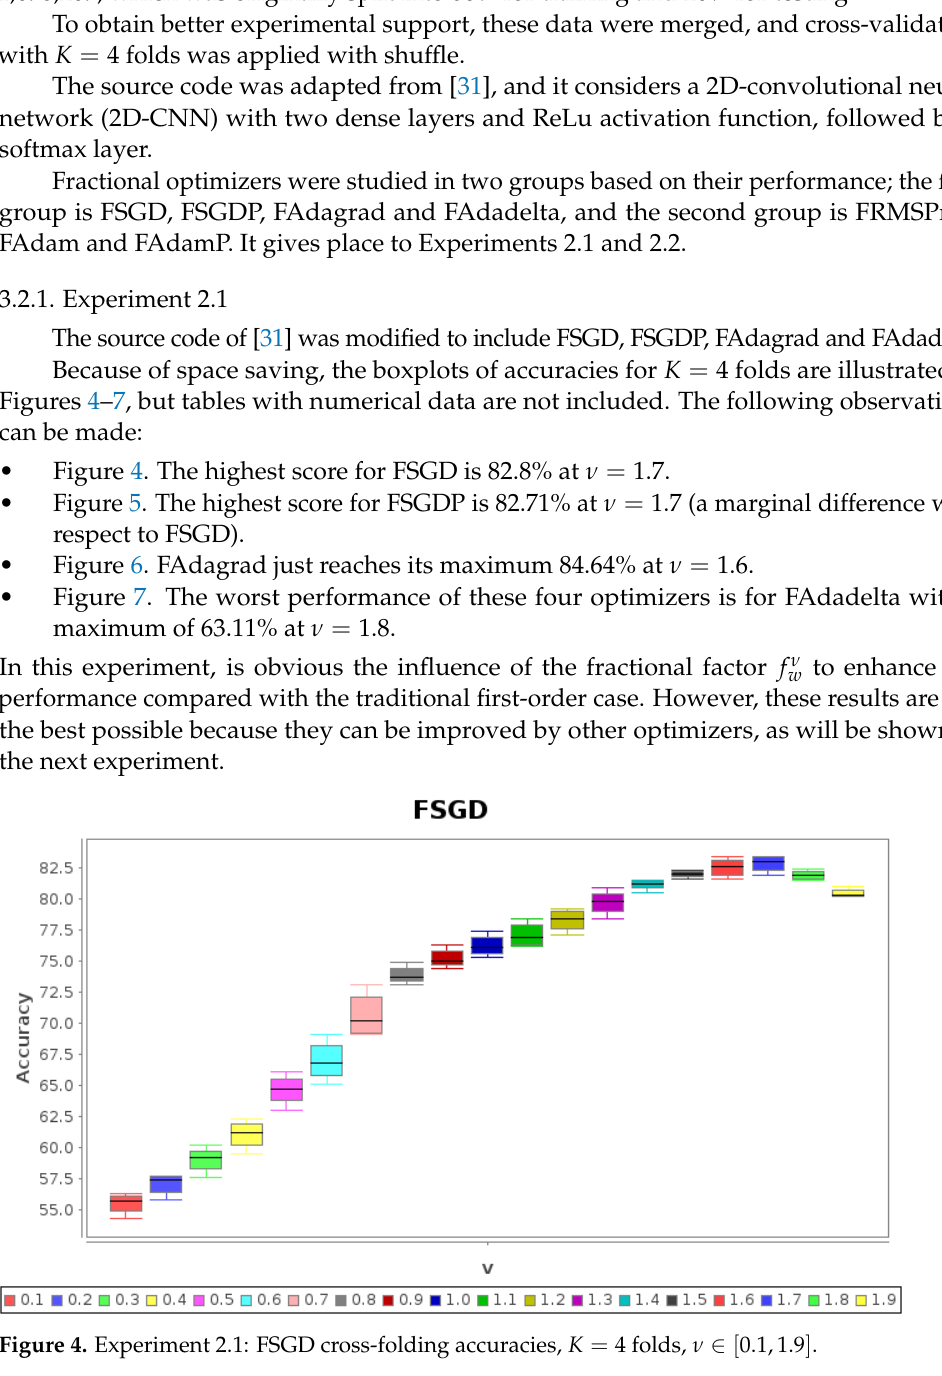
Figure 4. Experiment 2.1: FSGD cross-folding accuracies, K = 4 folds, ν ∈ [ 0.1,1.9 ]